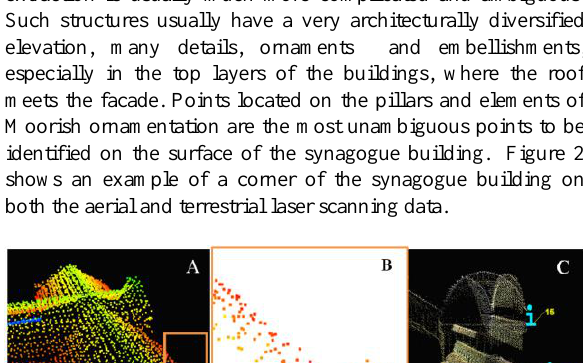
The average resolution of the point cloud was equal to 2.5cm.